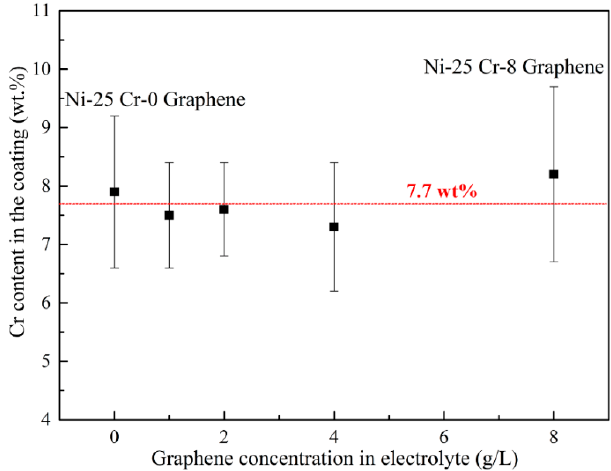
Figure 3. Content of Cr particles in the Ni–Cr–graphene coatings.